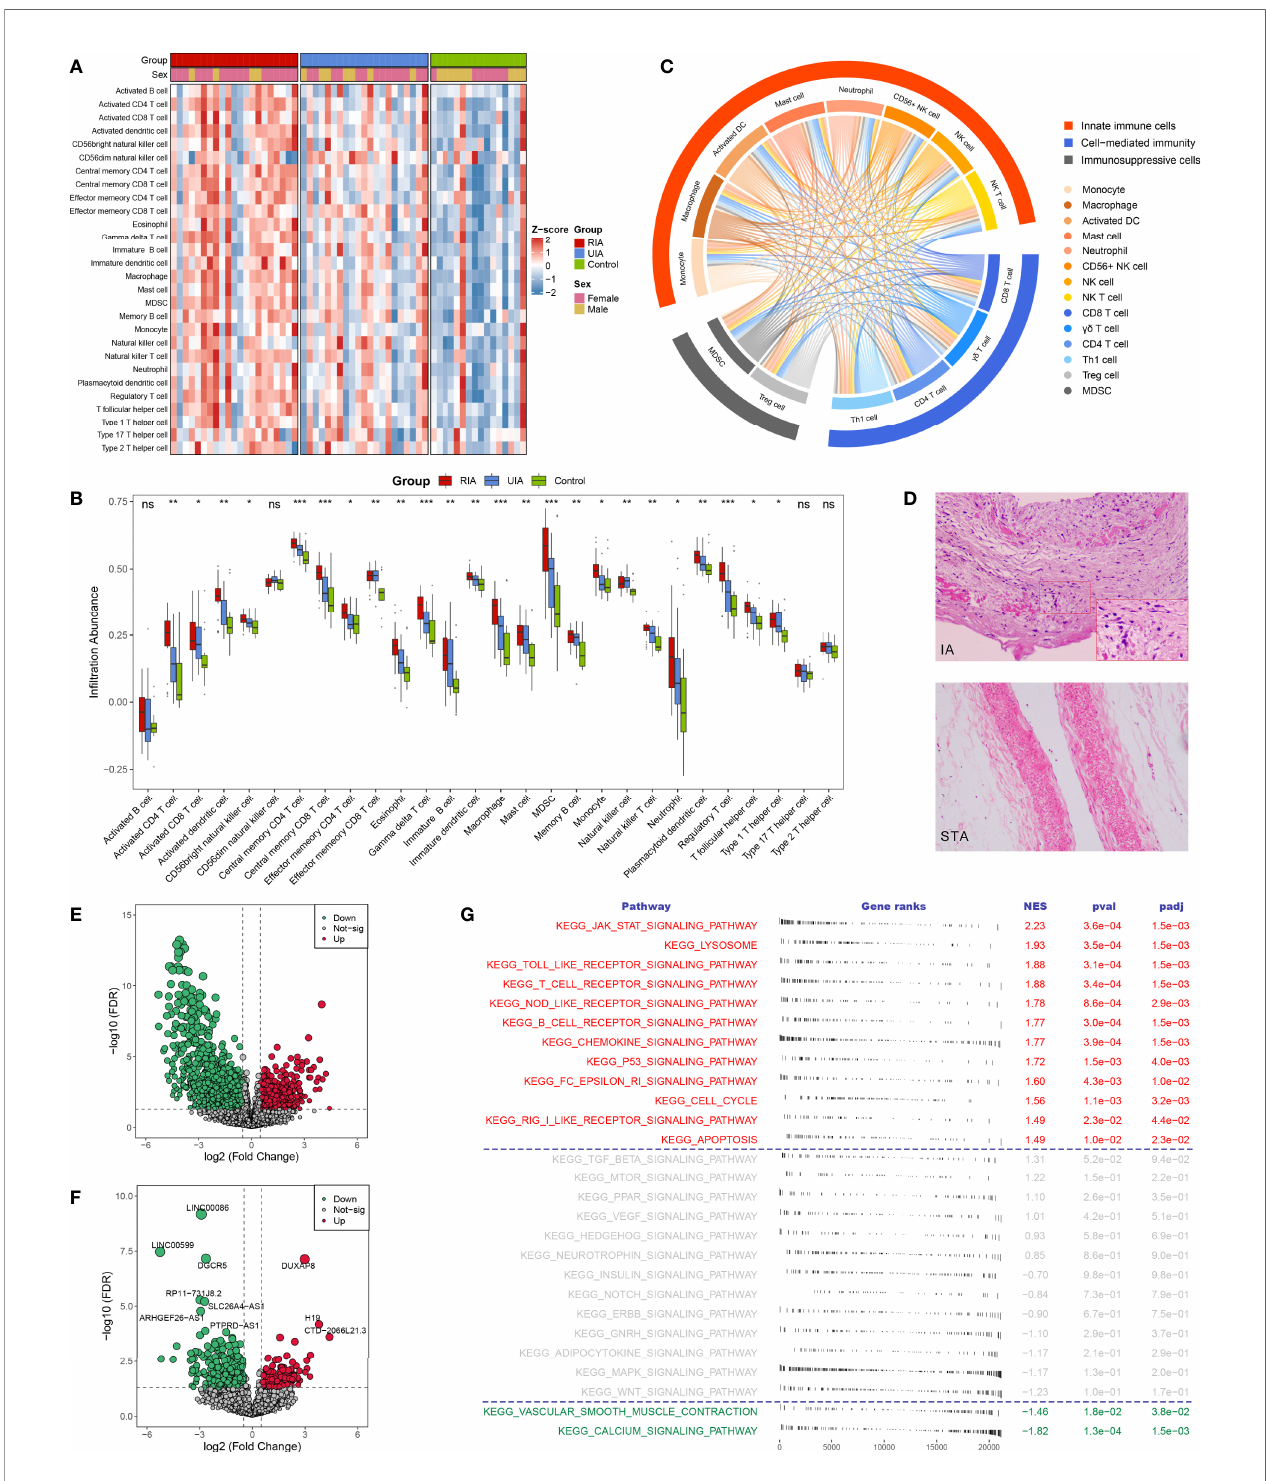
FIGURE 2 | The landscape of immune in fi ltration and aberrant signaling pathways. (A, B). Heatmap (A) and comparison boxplot (B) of 28 immune cell in fi ltration between RIA, UIA, and control groups. ns, P > 0.05; * P < 0.05, ** P < 0.01, *** P < 0.001. (C) Chord diagram of the correlation of 14 abnormal immune cells. The color line between two cells represented their positive relationship. (D) HE staining of IA and STA paraf fi n sections. Magni fi cation, 100×. (E, F). Volcano plots of DEmRNAs (E) and DElncRNAs (F) between IAs and controls. Red dots indicate up-regulated genes and green dots represent down-regulated genes. (G) GSEA analysis of 27 KEGG signaling pathways in IAs and controls. NES >0 indicates pathway activation and NES <0 indicates pathway inhibition. NES, normalized enrichment